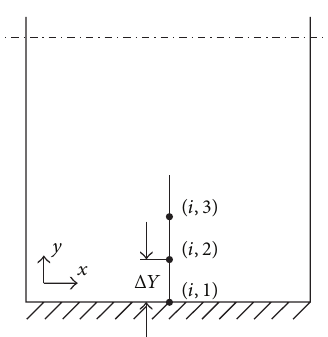
Figure 2: Schematic of the treatment for boundary conditions of vorticity-stream function